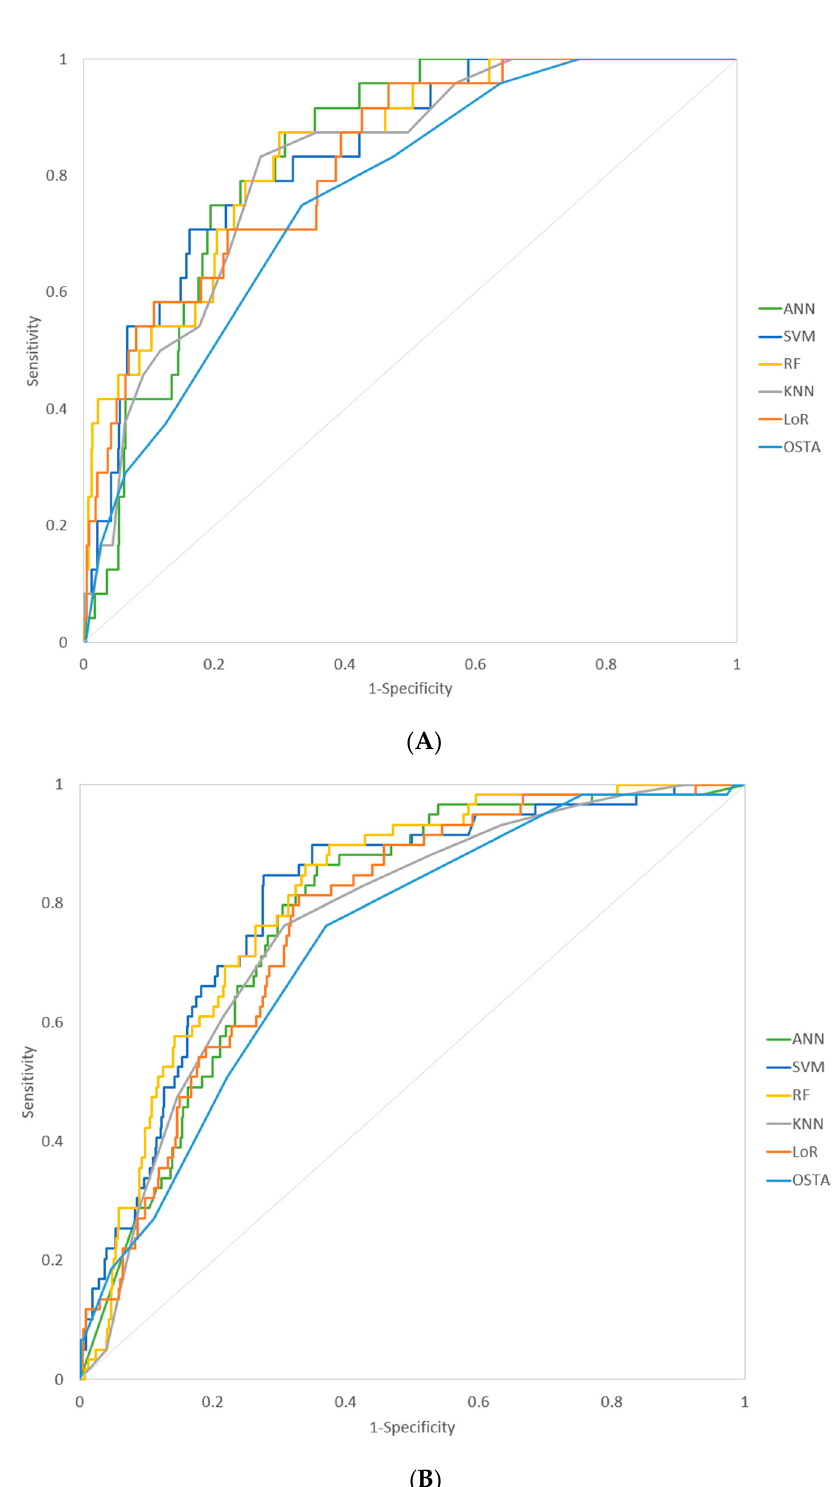
Figure 2. ( A )The ROC curves of different machine learning models and the OSTA model for pre-